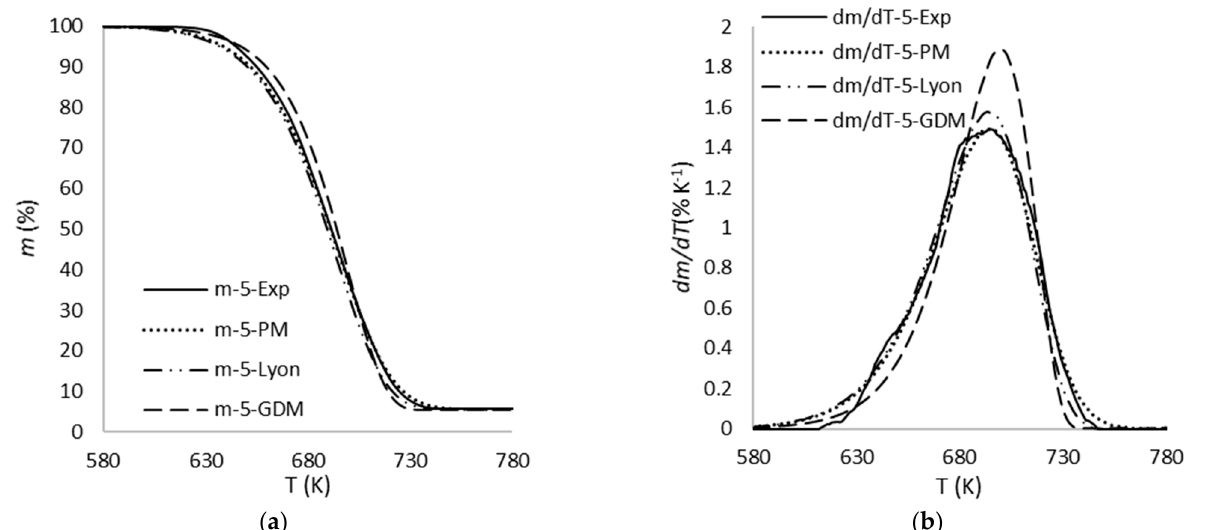
Figure 9. A comparison of experimental and calculated ( a ) mass and ( b ) dm / dT results for PA 6.6 at a heating rate of 5 K min − 1 .